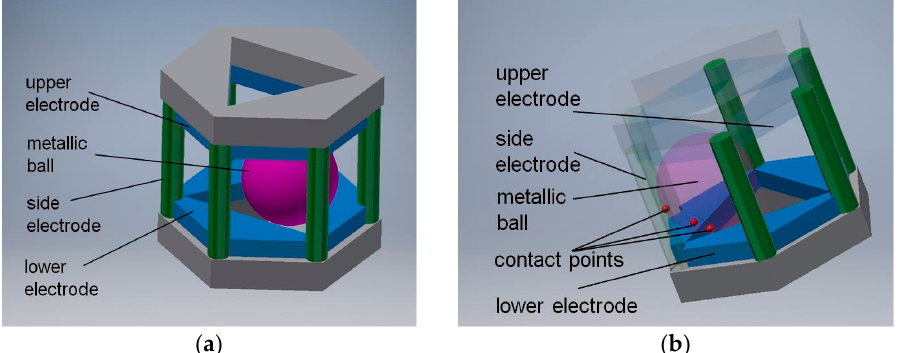
Figure 8. Sensor with six detection sub-ranges: ( a ) the structure; ( b ) principle of operation.